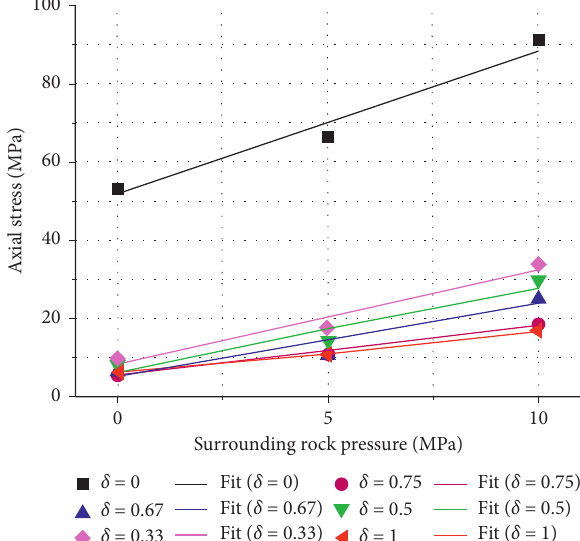
Figure 13: Fitting curve of Mohr–Coulomb criterion.